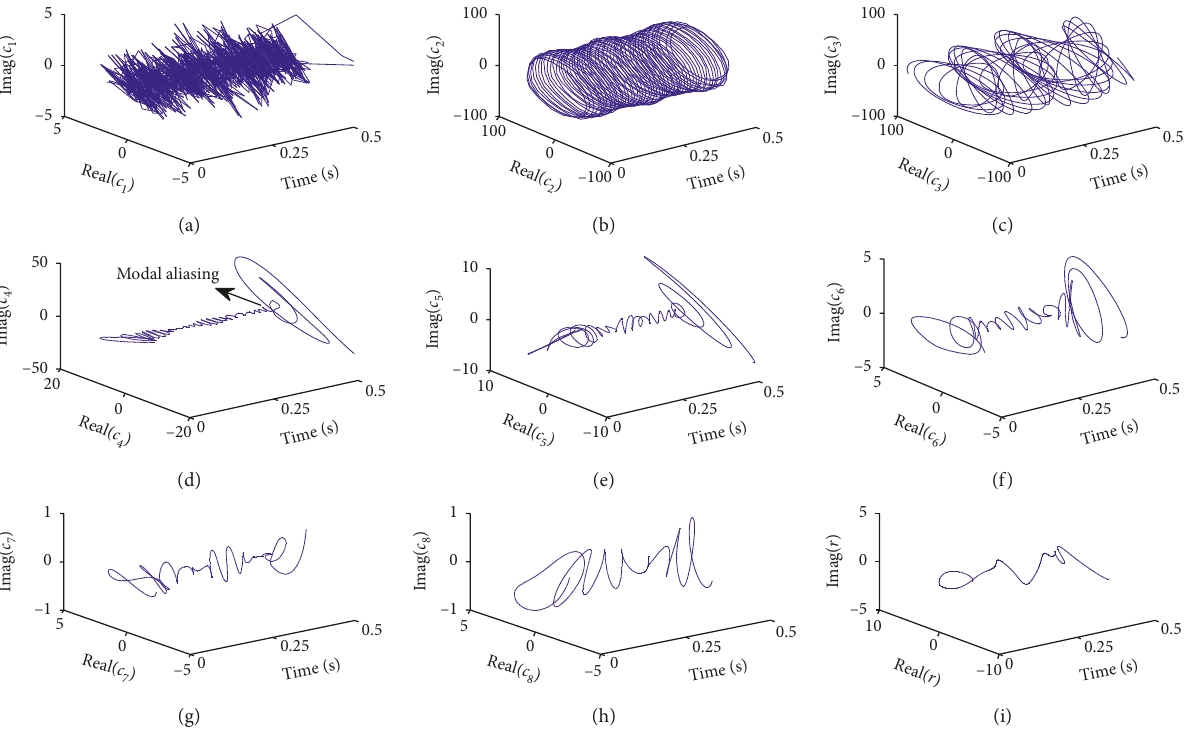
Figure 7: Decomposition results of the oil film oscillation signal using BEMD ( N